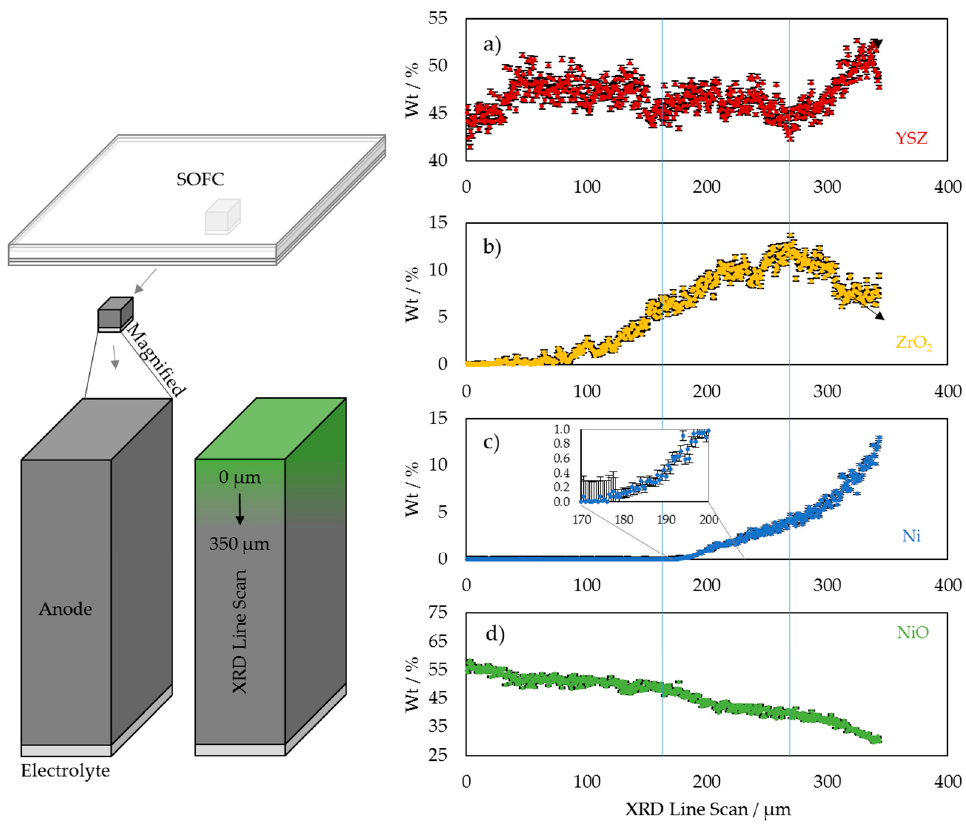
Figure 2. Crystallographic analysis via synchrotron XRD line scans. ( a ) YSZ (red), ( b ) ZrO2 (yellow), ( c ) Ni (blue), and ( d ) NiO (green).